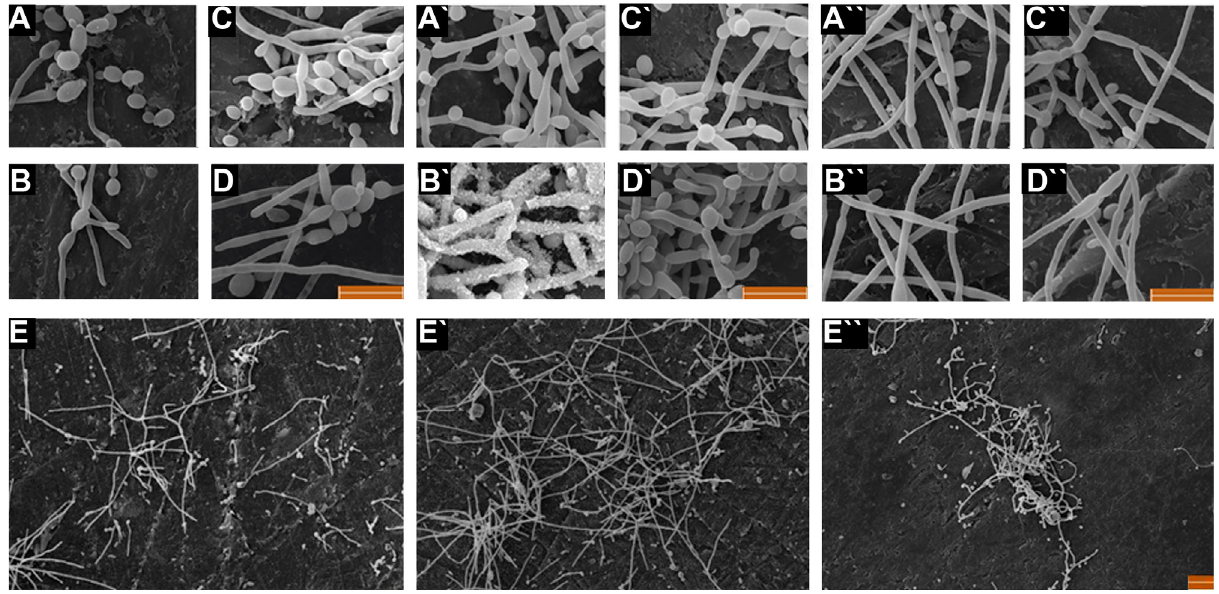
Figure 4- Scanning electron microscopy images of A, B, C, D, and E for A-type resin; A`, B`, C`, D` and E` for D type resin and A``, B``, C``, D`` and E`` for Q-type resin are Corega-tested surface, Polident-tested surface, Fittydent-tested surface, Control and Surface type, respectively. Bar is 10 µm. A- and Q-type resins showed more notched surface with deeply fissure (E and E``). A detailed analysis of the D (E`)-type resin surface displayed smooth and regular